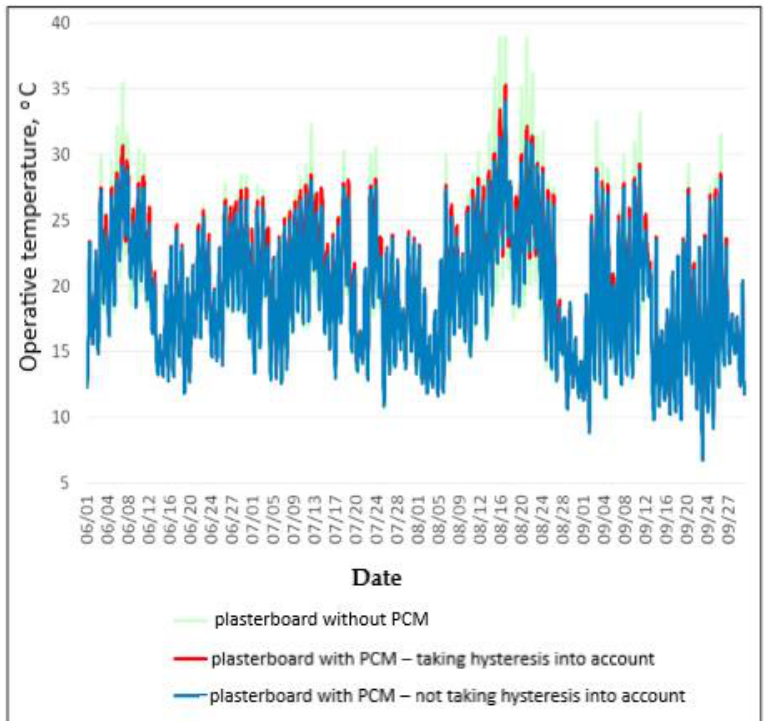
Figure 10. Operative temperature inside the analyzed building with Dupont boards.